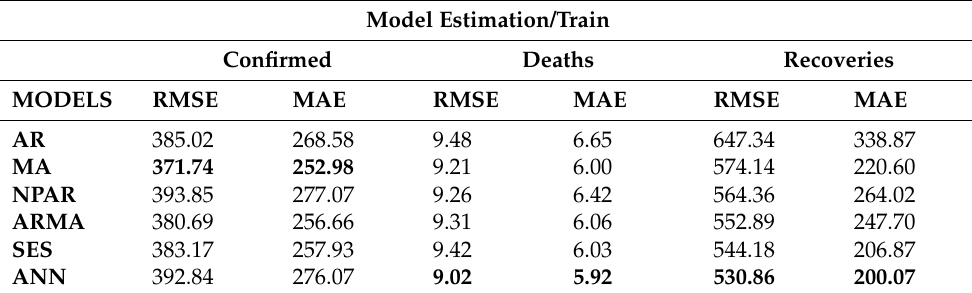
Table 3. Model Estimation/Train : One-day-ahead RMSE and MAE for confirmed cases, deaths, and recovered cases for all models.